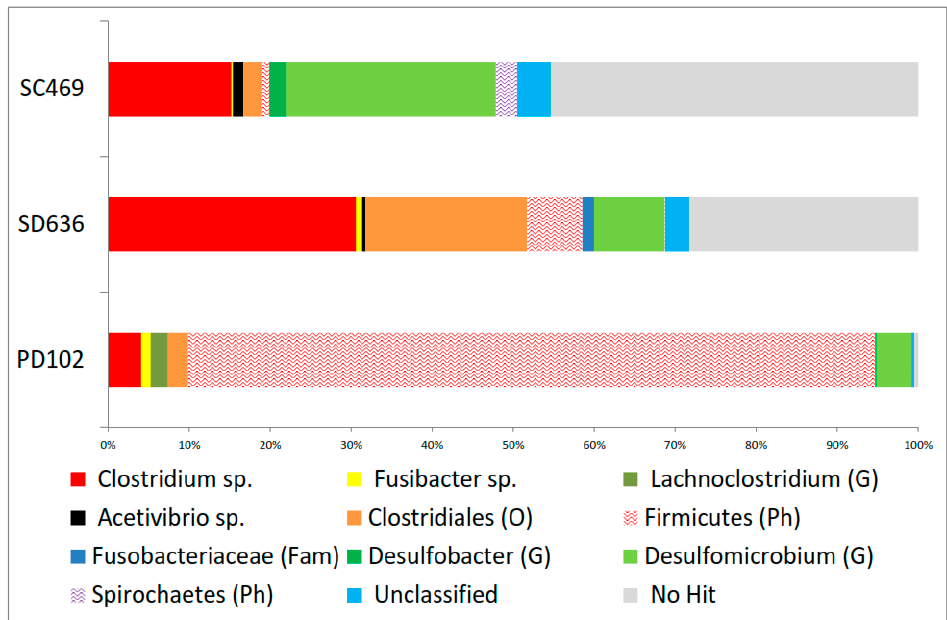
Figure 4. Microbial diversity structure of SC469, SD636 and PD102 biomass re-collected at the end of kinetic tests.